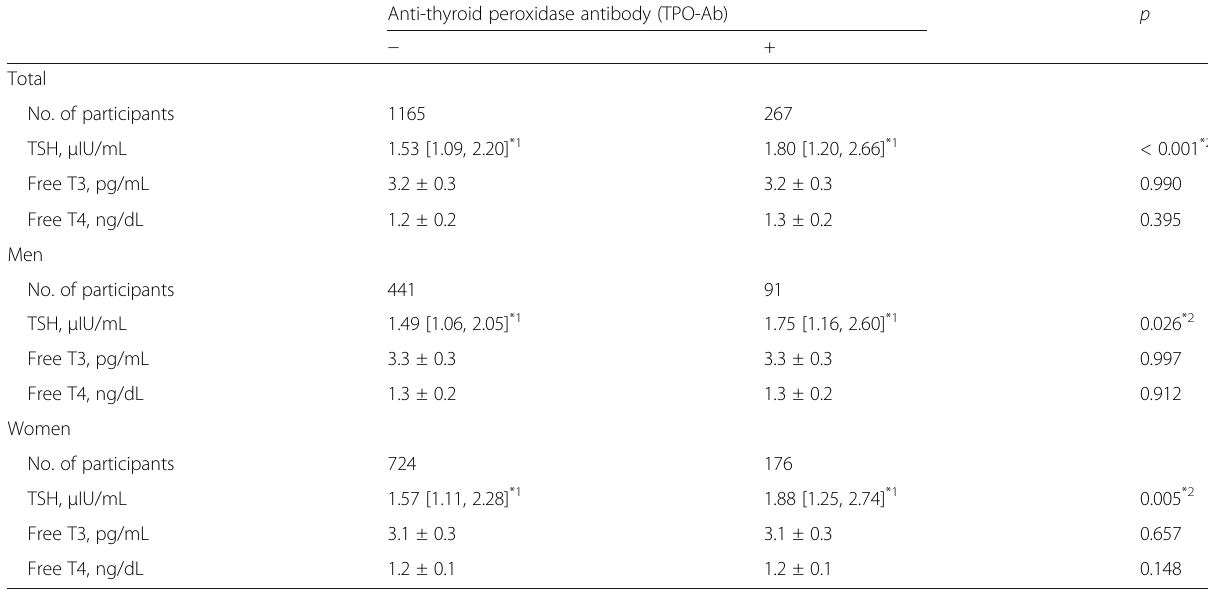
Table 2 Thyroid-related hormone by anti-thyroid peroxidase antibody (TPO-Ab) Anti-thyroid peroxidase antibody